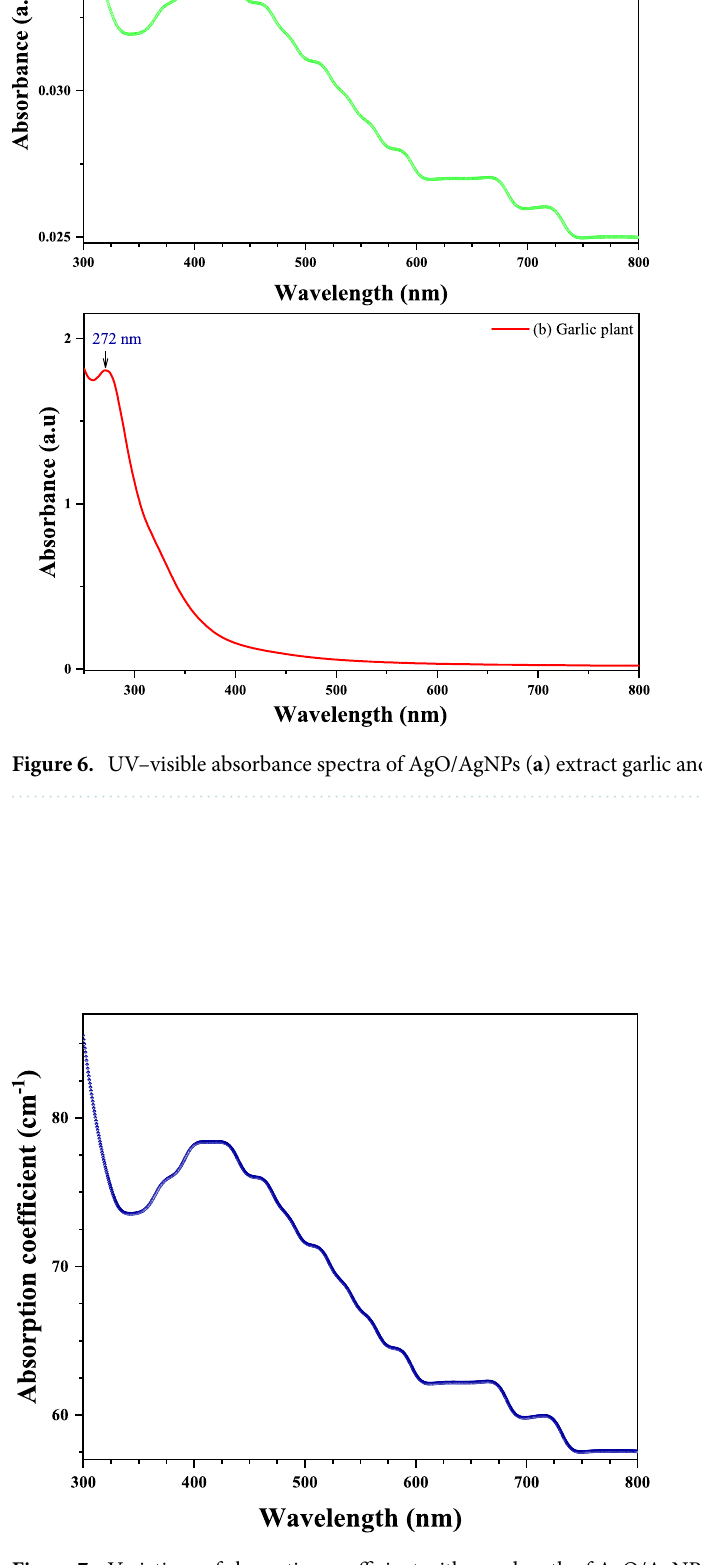
Figure 7. Variations of absorption coefficient with wavelength of